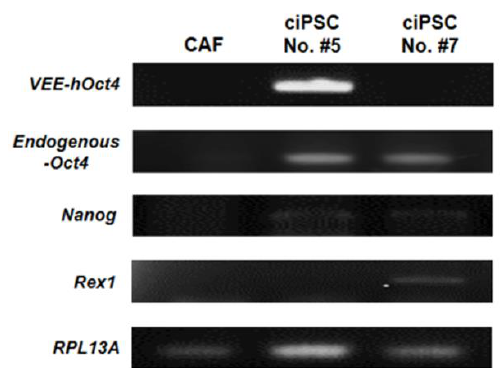
Figure 6. Gene expression analysis of the putative canine induced pluripotent stem cell (ciPSC) lines.